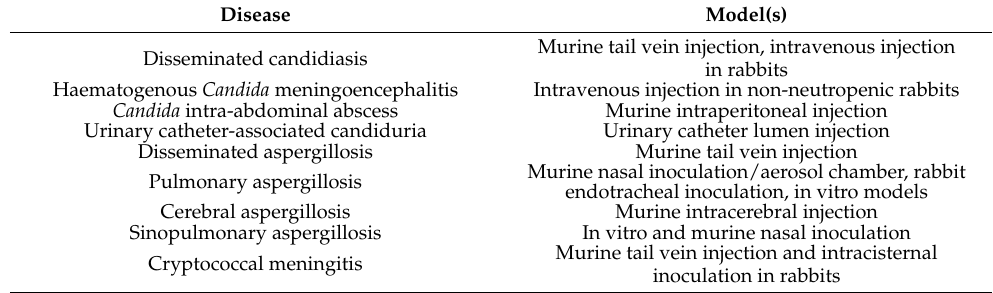
Table 1. Examples of preclinical systems used to model invasive fungal disease in vivo and in